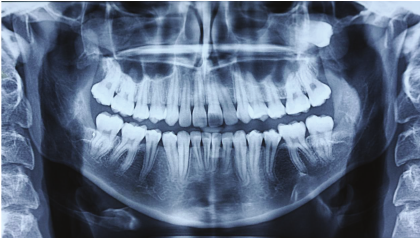
Figure 1: A panoramic radiograph revealed that the left maxillary third molar was displaced in a posterosuperior direction.